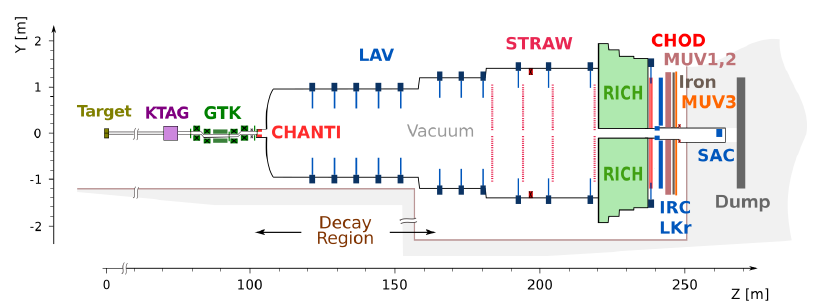
Figure 2. Schematics of the NA62 experiment at CERN